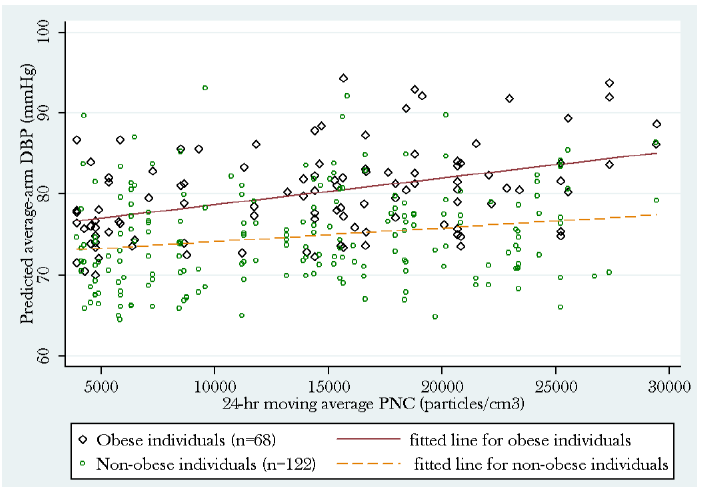
Figure 2. Subgroup analysis of the PNC model by obesity